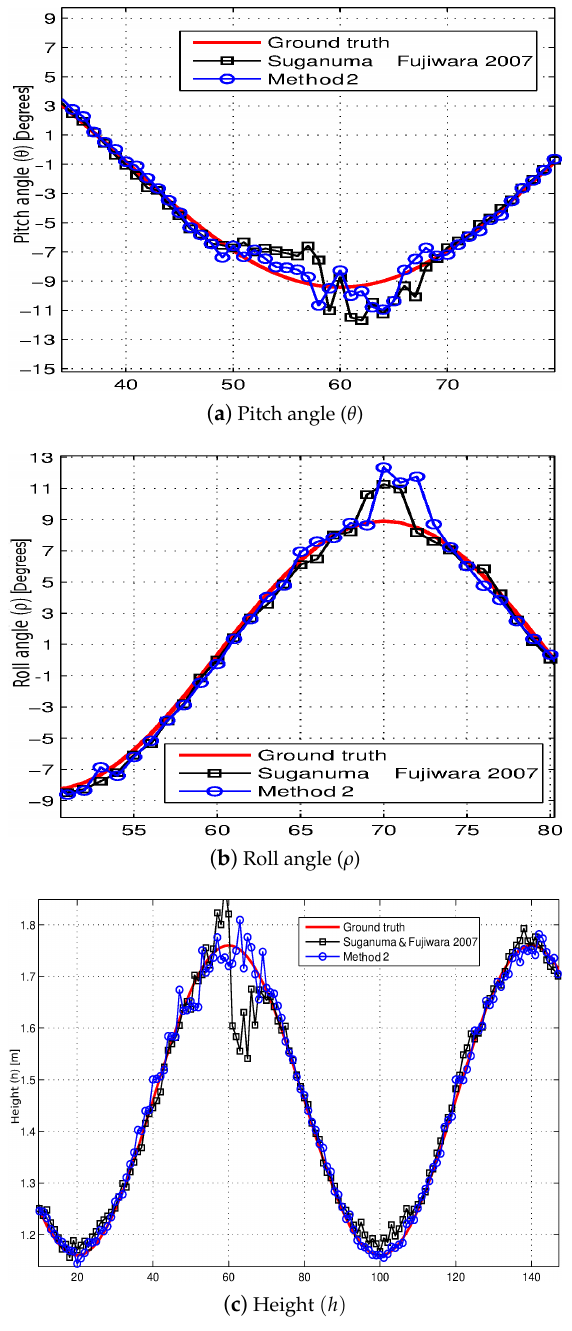
Figure 12. Comparison between the self-calibration results obtained by using the presented Method 2 and the method based on the virtual disparity map presented in